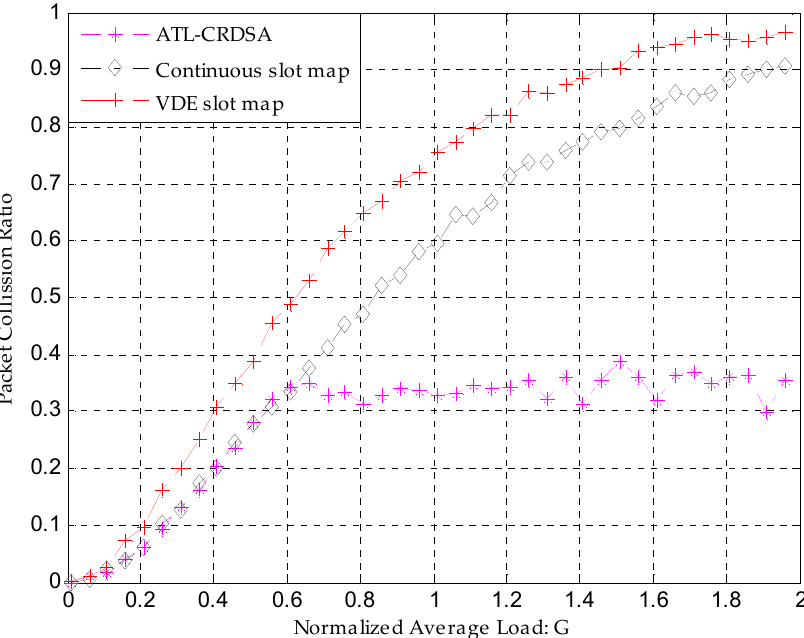
Figure 7. PacketcollisionratioofATL-CRDSAinVDEslotmapandCRDSAincontinuousandVDEslotmaps. Figure 7. Packet collision ratio of ATL-CRDSA in VDE slot map and CRDSA in continuous and VDE